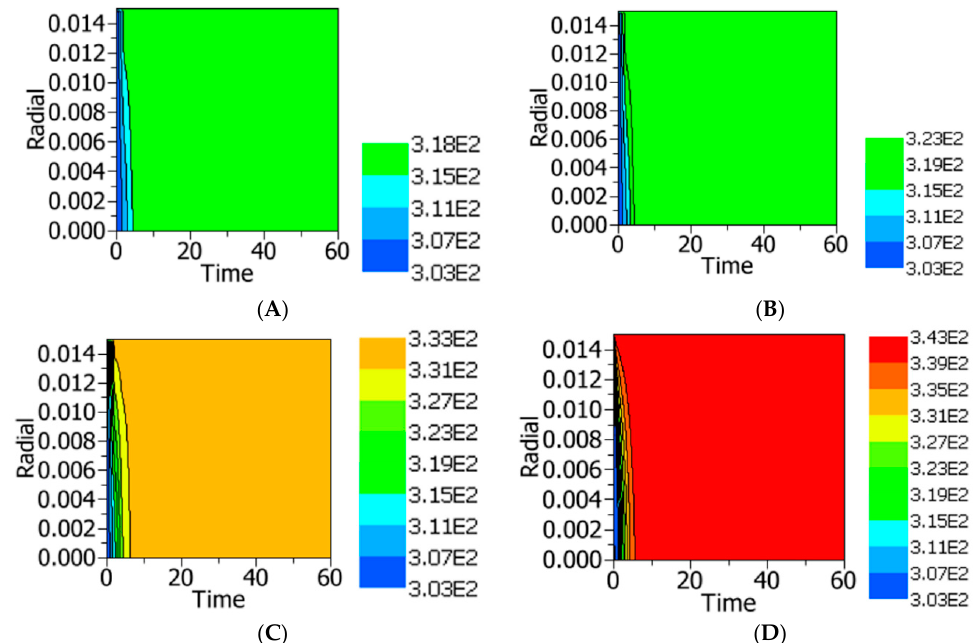
Figure 9. Contour plot of simulated heat distribution within OPF immersed in water at ( A —318 K, B —323 K, C —333 K and D —347 K).